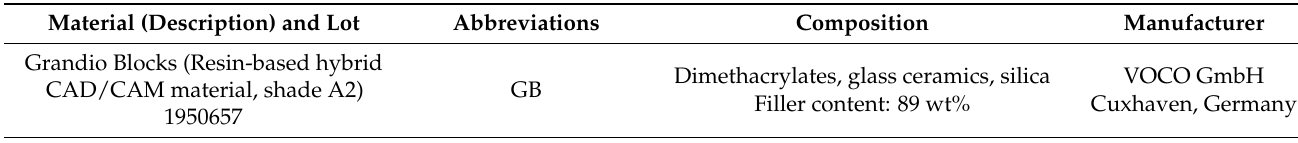
Table 1. Materials (description) and lot #, abbreviations, composition, and